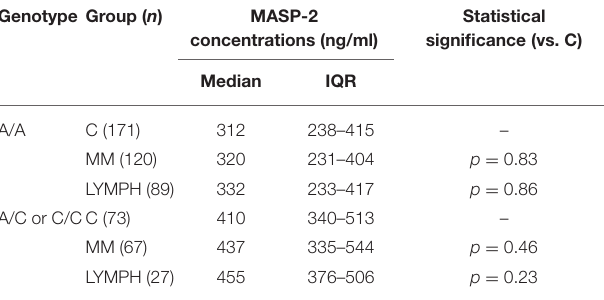
TABLE 8 | Serum MASP-2 concentrations in controls and patients (sample 1), corresponding to MASP2 genotypes ( + 1111 A > C SNP). Genotype Group ( n